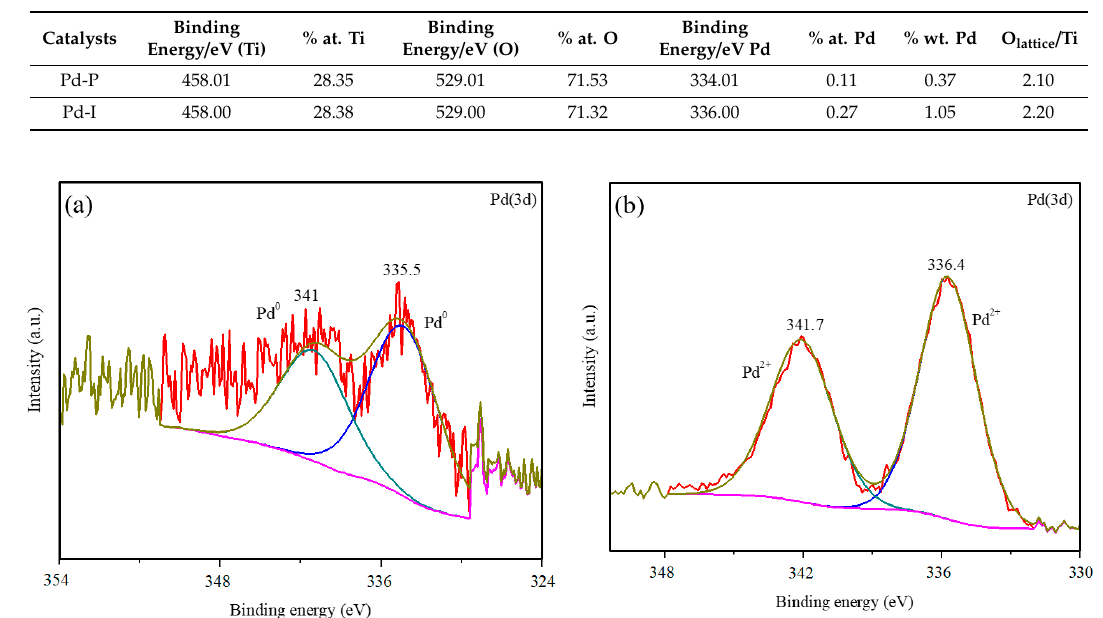
Figure 4. XPS of Pd-modified samples: ( a ) Pd (3d) of Pd-P and ( b ) Pd (3d) of Pd-I.